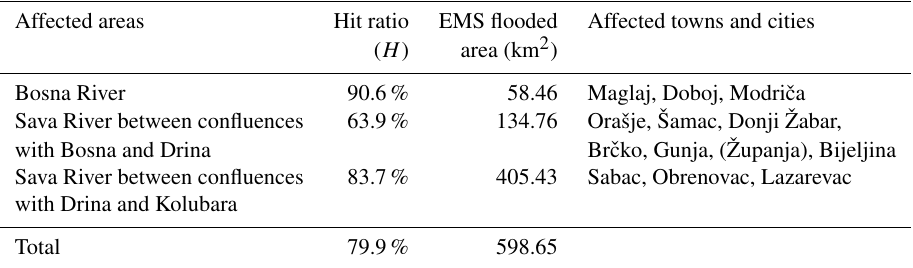
Table 3. Scores of the hit ratio ( H ) for the considered flooded sectors and affected towns and cities. Names in parentheses refer to towns and cities wrongly predicted as flooded; otherwise towns and cities have been correctly predicted as